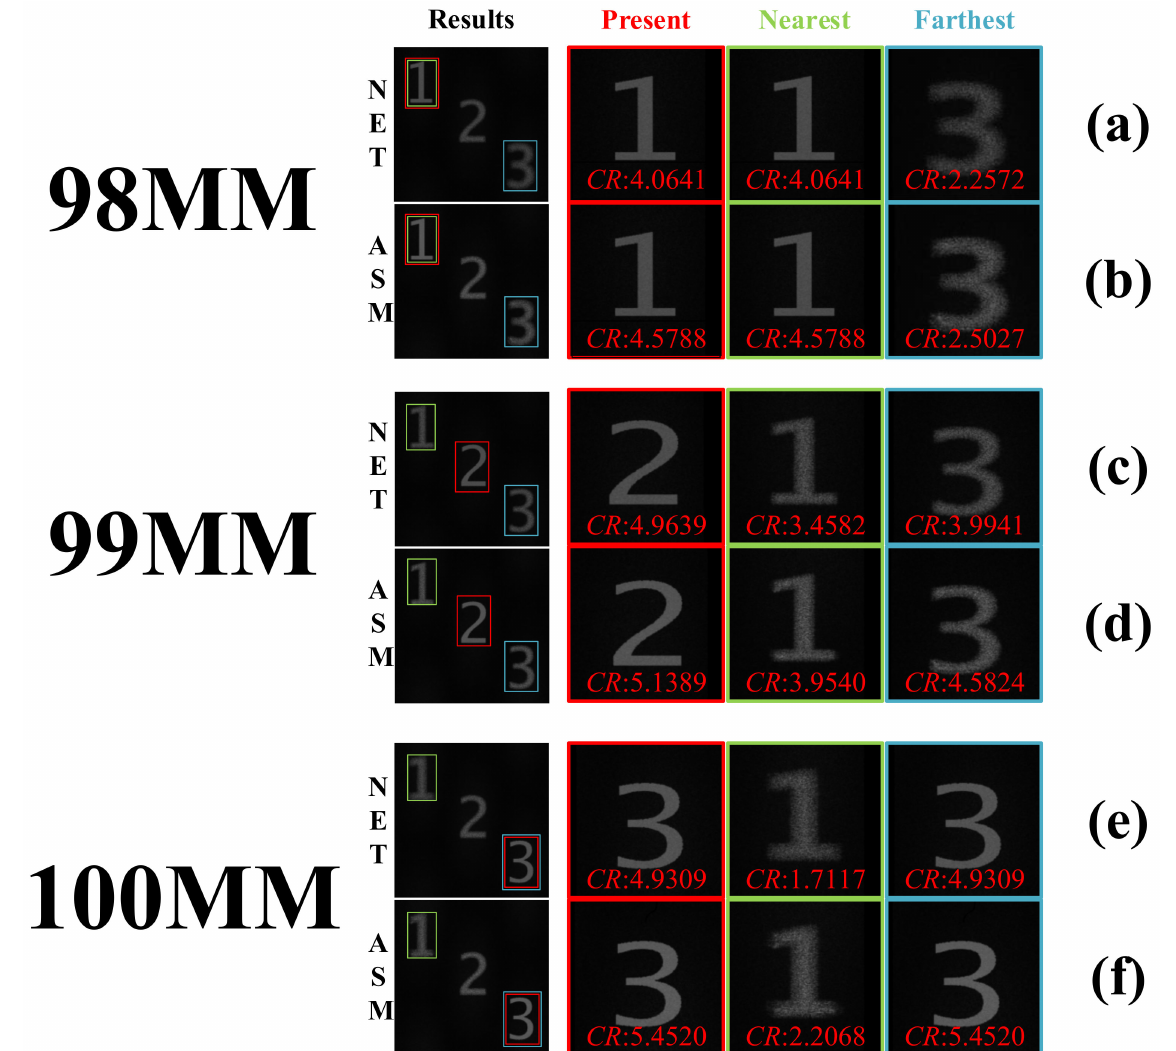
Figure 6. Comparison of numerical reconstruction results of multi-plane iterative ASM and network. Rows ( a , c , e ) are the reconstructed image results of the network and the magnified images corresponding to the details; rows ( b , d , f ) are the reconstructed image results of the multi-plane iterative ASM and the magnified details images. Three columns on the right of Figure 6 are all magnification results corresponding to the individual digits in the reconstructed